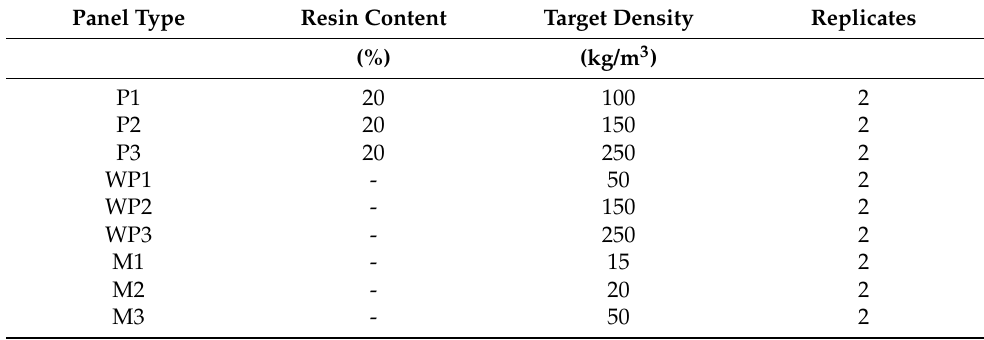
Table 1. DOE for the production of peat moss specimens. Panel Type Resin